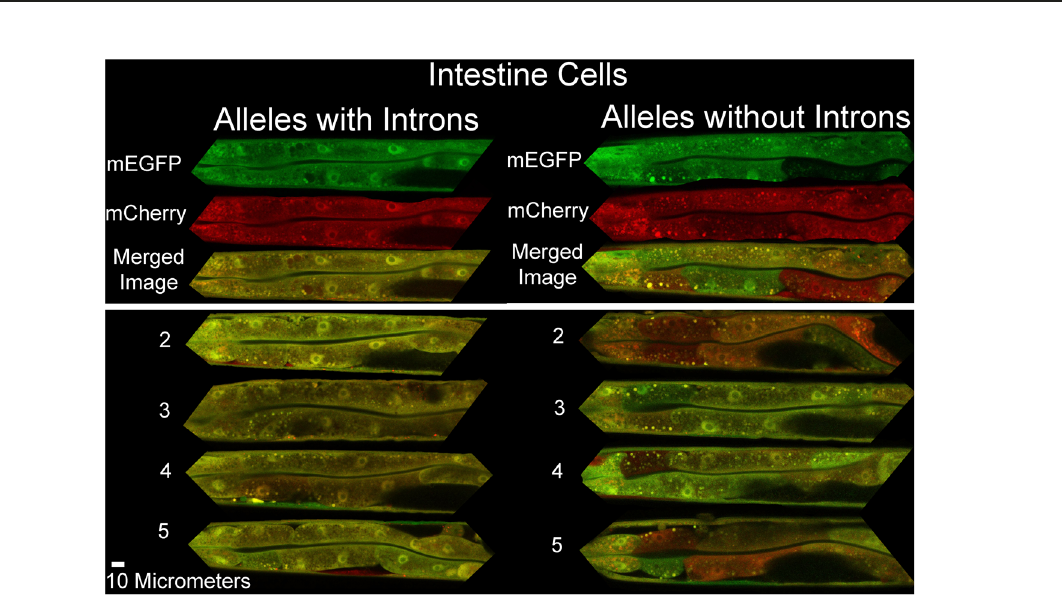
Fig. 5 Micrographs of stochastic allele bias in intestine cells. Composite images show merged red/green signal micrographs of animals expressing hsp-90 reporter alleles in their intestines. Top panel shows the individual red signal, green signal and merged micrographs. Left column shows sections of animals with intestine cells expressing alleles with introns. Right column shows sections of animals with intestine cells expressing alleles without introns. We arbitrarily selected fi ve images per group from the z stacks from the four independent experiments used to generate the data in Fig.